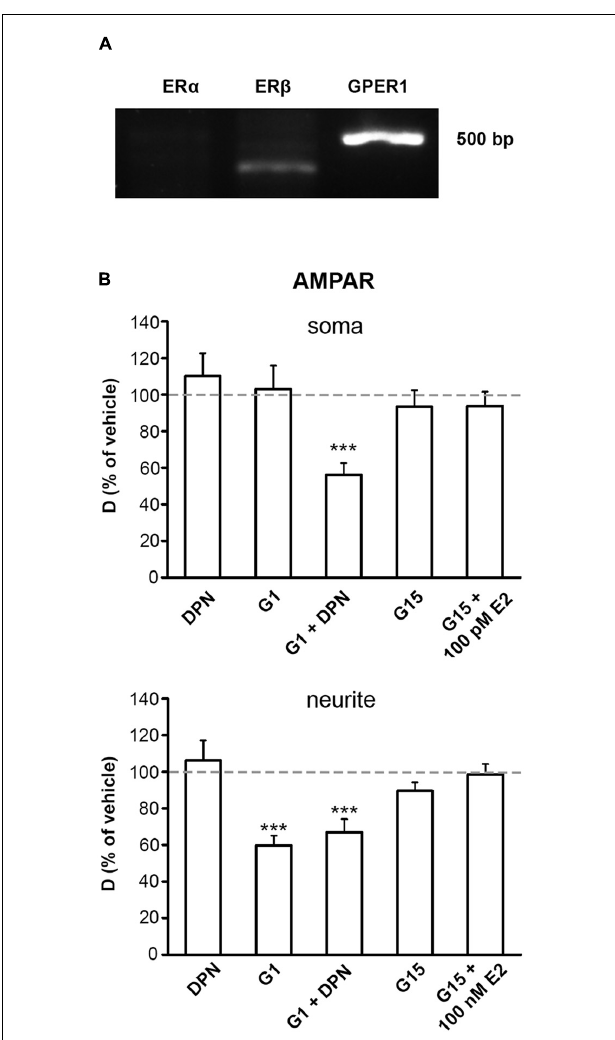
FIGURE 3 | Effect of estrogen receptor modulation on the surface movement of GluR2-AMPAR. (A) Representative PCR gel electrophoresis image depicting the expression of estrogen receptor beta (ER β ) and G protein-coupled estrogen receptor 1 (GPER1) mRNA in dPC12. Estrogen receptor alpha (ER α ) mRNA was not detected. (B) Histograms demonstrate the mean D AMPAR as a percentage of vehicle control on somas and neurites in the presence of the estrogen receptor, β (ER β ) agonist diarylpropionitrile (DPN), a GPER1 agonist (G1), G1+DPN together, a GPER1 antagonist (G15) and G15+E2 (with 100 pM of E2 on the somas and 100 nM of E2 on the neurites) (mean ± SEM; n = 215–641 trajectories). *** p <